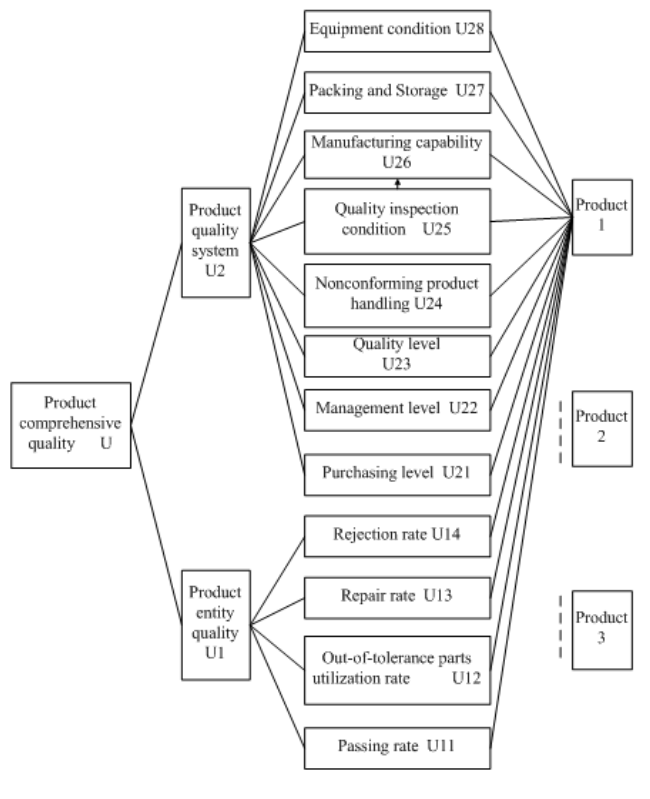
Figure.2. System structure